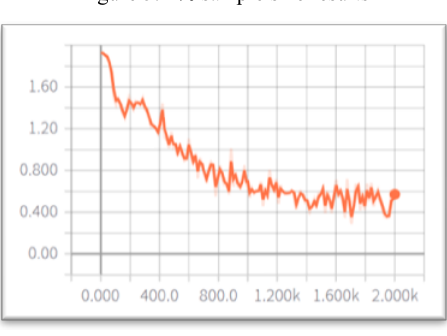
Figure 3. The Decline Process of Risk Function with the Increase of Rounds Figure 6. 4% sample size